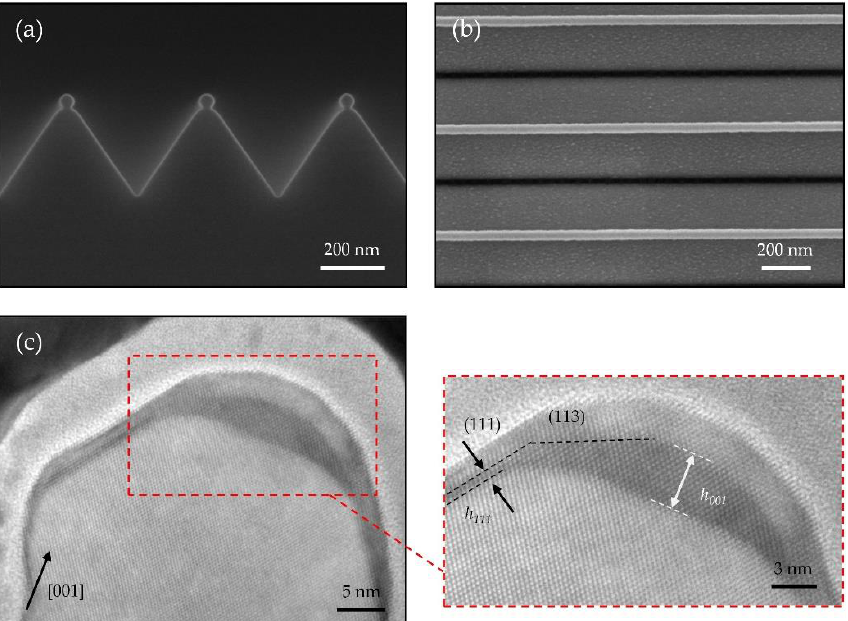
Figure 8. ( a ) Cross-sectional and ( b ) top view SEM images of the Ge/Si core/shell NW arrays. ( c ) Cross-sectional HRTEM image of a Ge/Si core/shell NW. Inset: a zoom-in HRTEM shows the two {113} side facets and the flat (001) top surface.